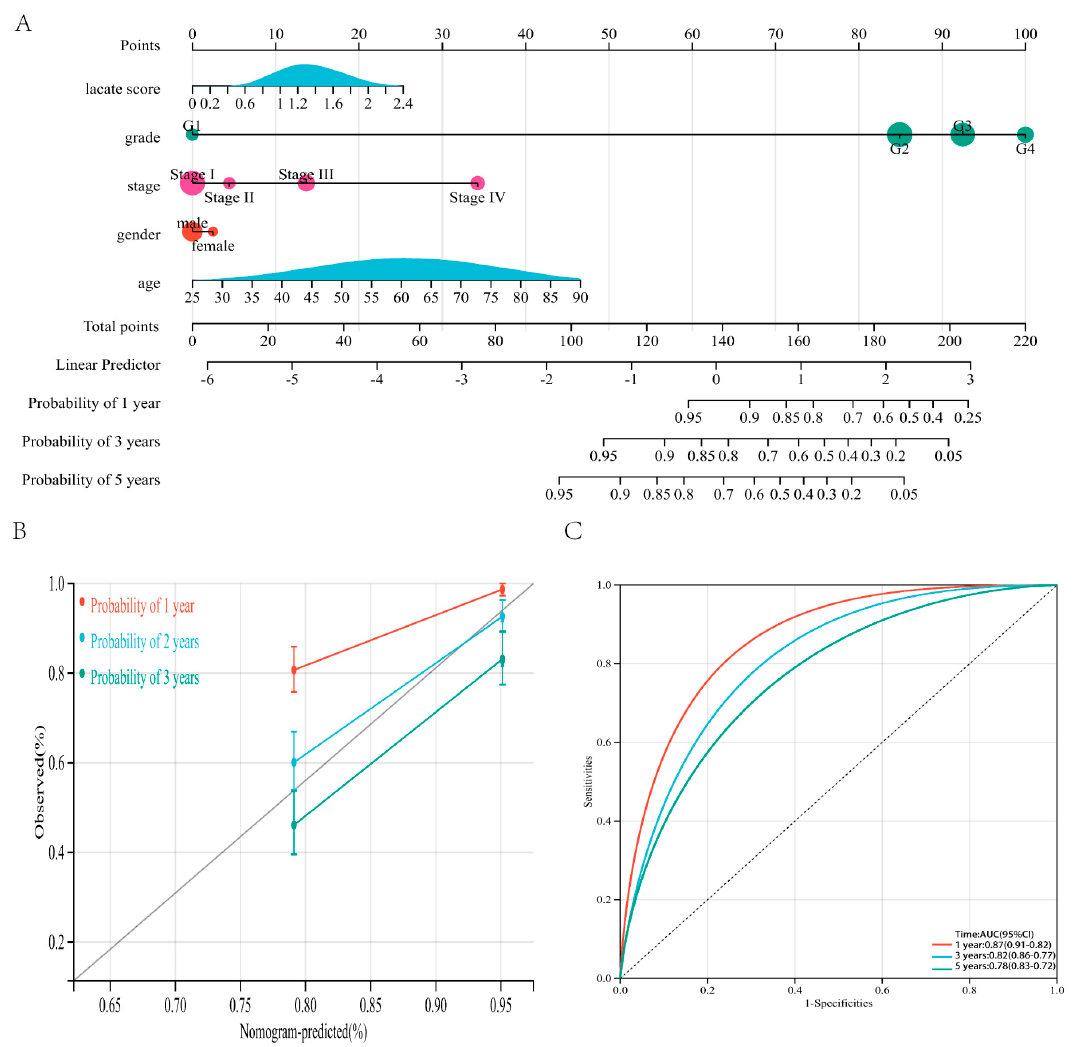
Figure 5. Nomogram prediction model can accurately predict the prognosis of patients. ( A , B ) Nomogram based on prognostic model and clinicopathological information. ( C ) ROC curve of the TCGA cohort.